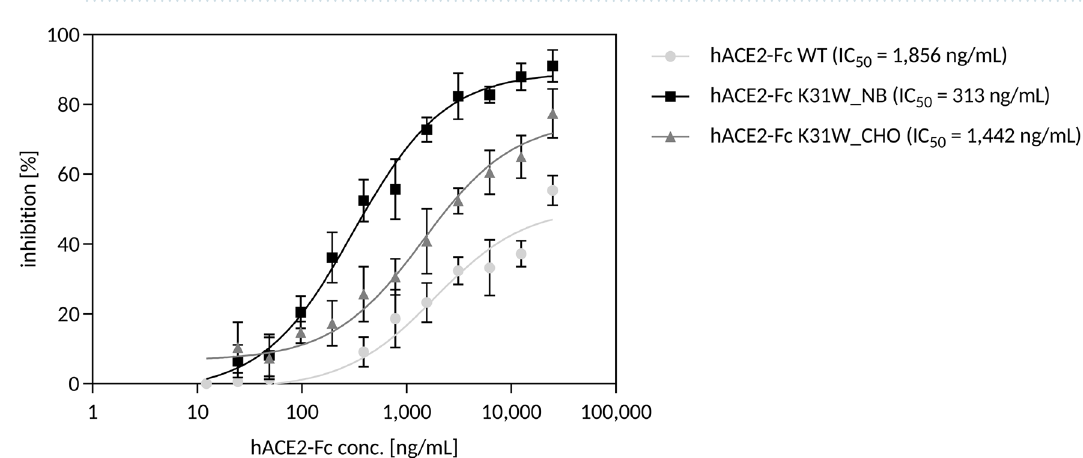
Figure 5. hACE2-Fc K31W inhibits infection by the SARS-CoV-2 Beta variant (MOI: 0.0003) to a greater extent than hACE2-Fc wild type (WT). ( a ), qRT-PCR analysis was used to determine the inhibiting effect of hACE2-Fc WT and hACE2-Fc K31W in concentrations between 0.78 and 25 µg/mL (25–6.25 µg/mL and 3.13– 0.78 µg/mL in separate experiments) in virus neutralization assays in VeroE6 cells. No substance (“Untreated”) and no virus (“Not infected”) served as positive and negative controls. Data are presented as mean ± SEM of 6 replicates each. ( b ) Immunohistochemical staining using a monoclonal anti-SARS-CoV-2 Nucleocapsid antibody in combination with a HRP-conjugated secondary antibody was implemented to stain virus-infected cells after the virus neutralization assays with hACE2-Fc concentrations between 3.13 and 0.78 µg/mL. Representative bright-field-microscope images (40 × magnification) of VeroE6 cells are presented.